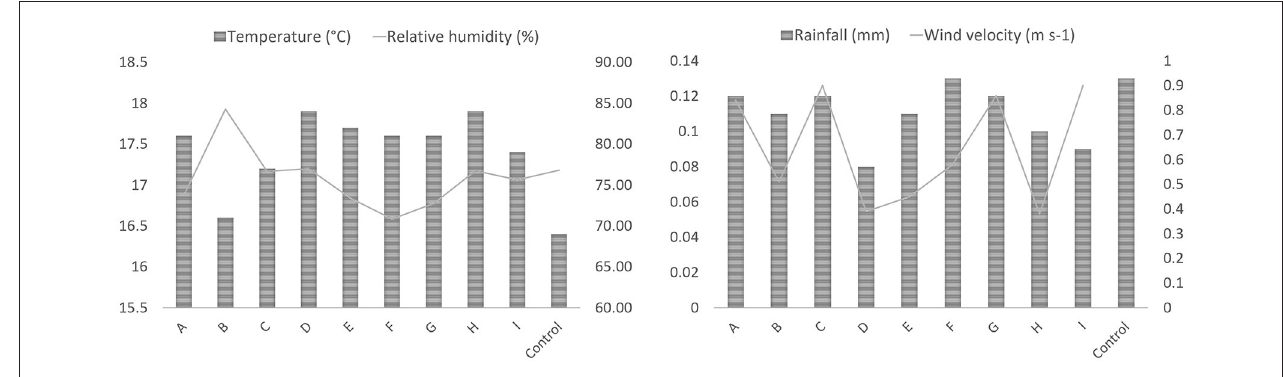
FIGURE 2 | Weather conditions: mean temperature, humidity, rainfall, and wind velocity for the 9 urban gardens and the control site during the period of exposure. results. It is also possible that the exposure period (45 days) was not enough to cause accumulations. This exposure was chosen because of the growth plant cycles of spinach and